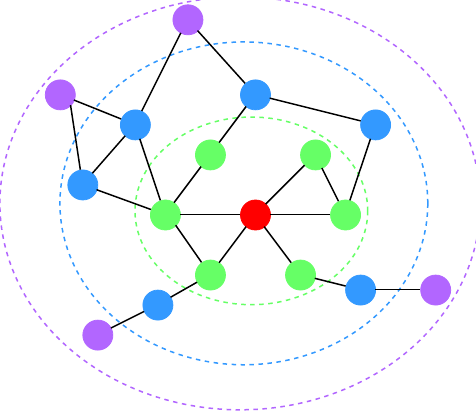
Figure 1. Ego networks of the ego vertex, the red